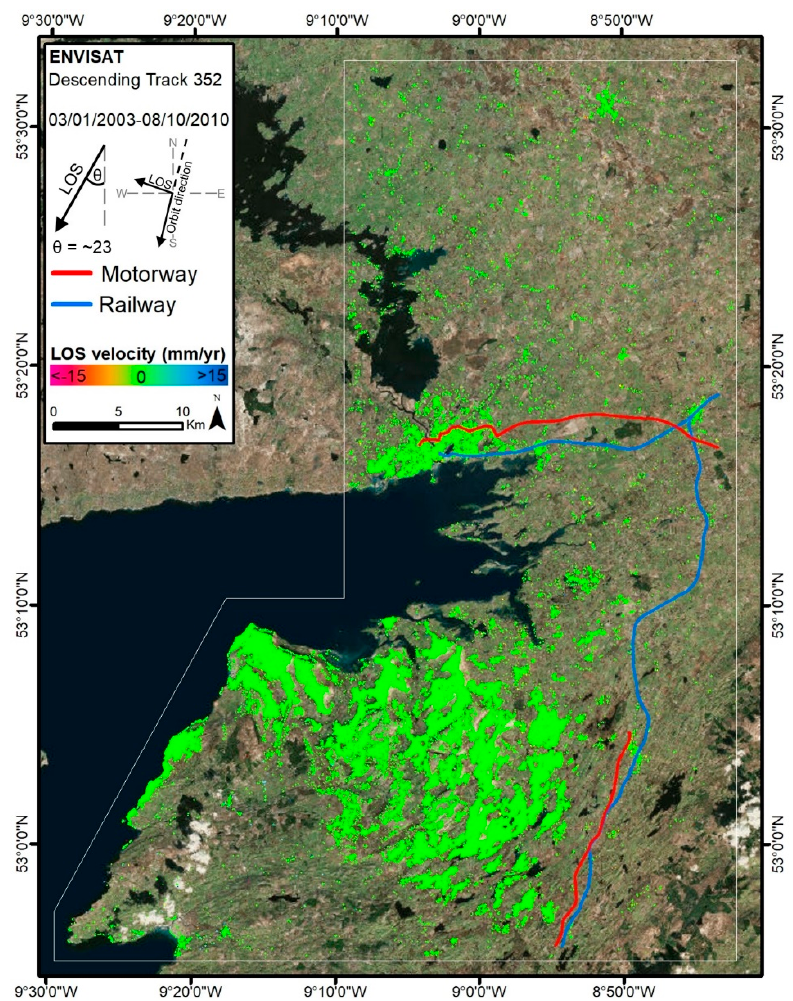
Figure 8. LOS velocity map of AOI-1 obtained from ENVISAT images with the PS-InSAR approach. SAR imagery date range: January 2003–October 2010. The sketch illustrates the satellite’s acquisition direction in respect to the orbit ( right ) and the LOS angle in respect to the vertical direction ( left ). Base image source: Esri, DigitalGlobe, GeoEye, Earth Geographics, CNES/Airbus DS, USDA, USGS, AeroGRID, IGN, and the GIS User Community.